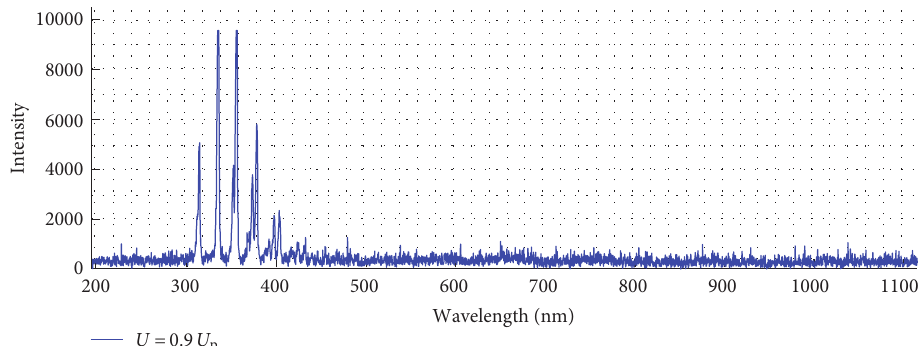
Figure 3: Optical spectrum registered in the vicinity of the aluminium line during measurements under voltage equal to 0.9 U and distance d =36 cm.